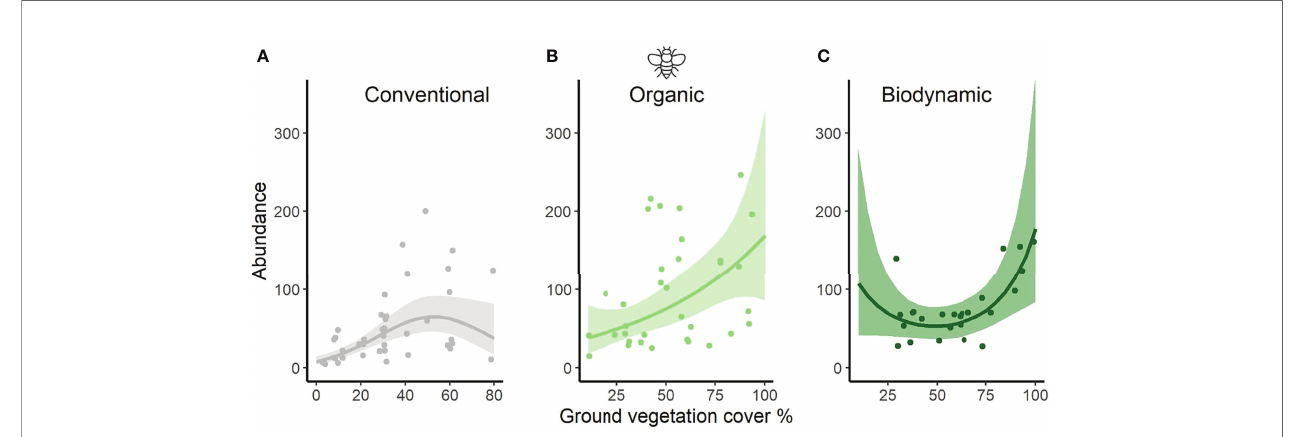
FIGURE 4 | Effects of ground vegetation cover on invertebrate abundance as obtained from sweep-netting samples (epiphytic invertebrates represented by dipterans), modulated by management regime shown for (A) conventional, (B) organic, and (C) biodynamic management separately. Plotted are predicted estimates from the interaction term, with means (solid lines) and 95% con fi dence intervals (CI, shaded area). Points show the raw data, while the x-axes were restricted to the value ranges of ground vegetation coverage per management regime (C: 0-80%; O: 10-100%; BD: 10-100%). The effects of ground vegetation cover in organic and biodynamic vineyards are signi fi cantly different from the effects in conventional vineyards. The large overlap of the CI for organic and biodynamic translates into an absence of signi fi cant effects between them. Note the particularly small sample sizes for biodynamic in the lowest values (left hand) of the ground vegetation cover gradient and vice versa for conventional at the highest values (right hand) of the